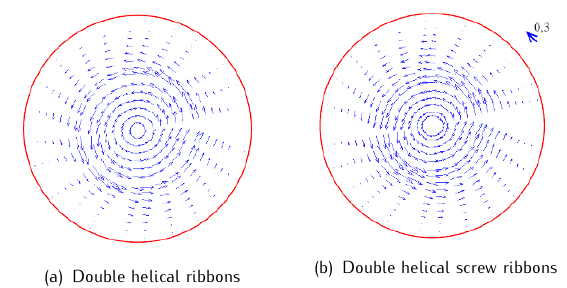
Figure 2. Flows patterns induced in r-